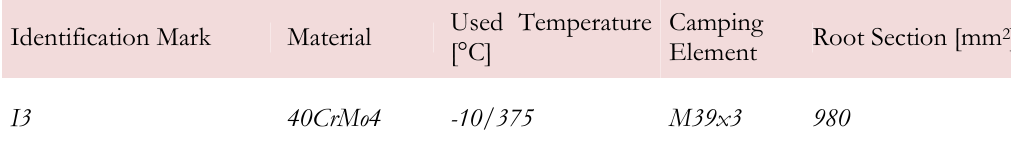
Table 2: Identification Characteristics